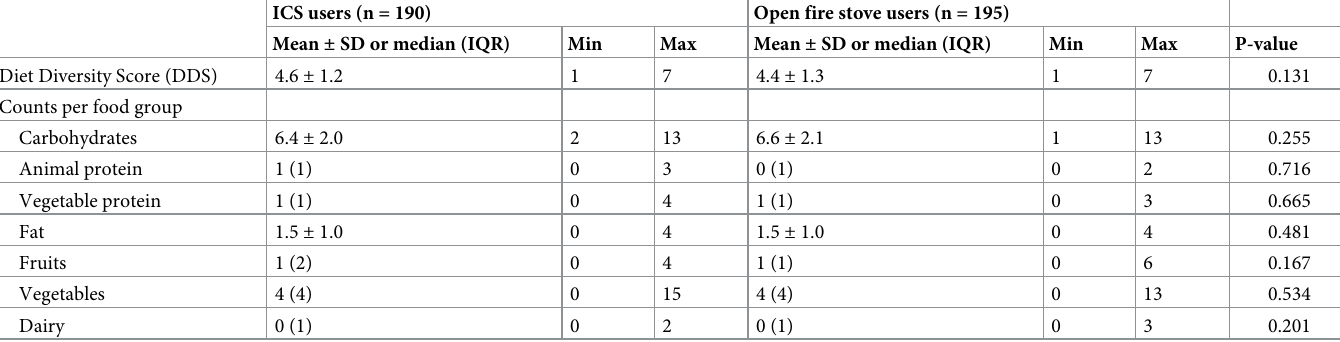
Table 2. Diet Diversity Score (DDS) and frequency of food groups among improved cookstoves and open fire stove users of the provinces of San Marcos and Caja- bamba,